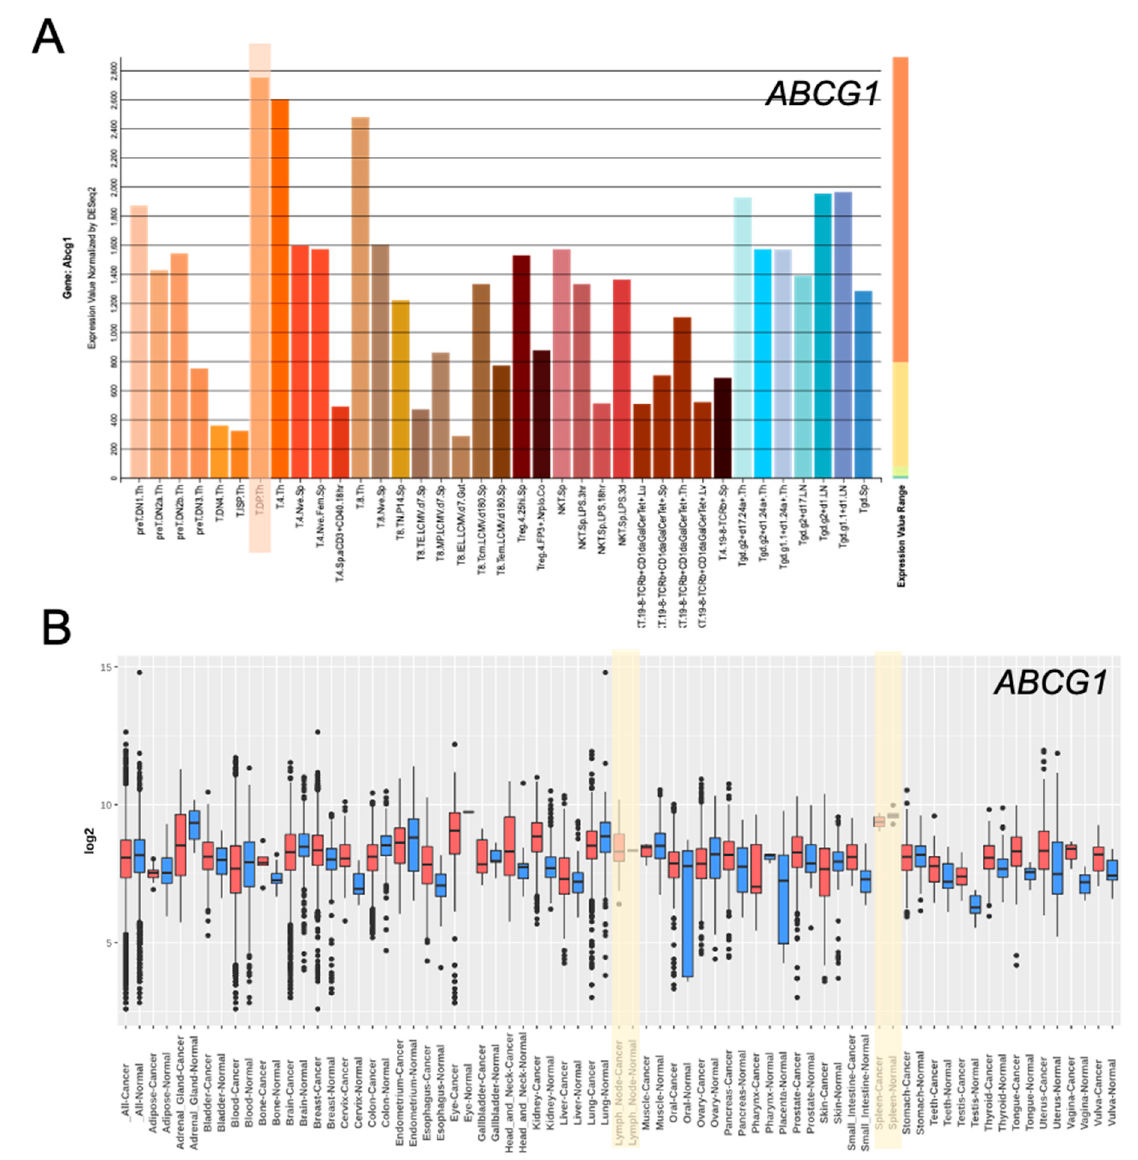
Figure 2. ABCG1 expression is high in double positive (DP) thymocytes and within the spleen. ( A ) Abcg1 expression for different T cell subpopulations shown as Expression Value normalized by DESeq2 and analyzed by using the ImmGen database and online platform (http://rstats.immgen.org/Skyline/skyline.html, accessed on 7 July 2021). ( B ) ABCG1 expression in different tissues analyzed by using the GENT2 platform to explore gene expression in normal and tumor tissues (http://gent2.appex.kr/gent2/, accessed on 7 July 2021).